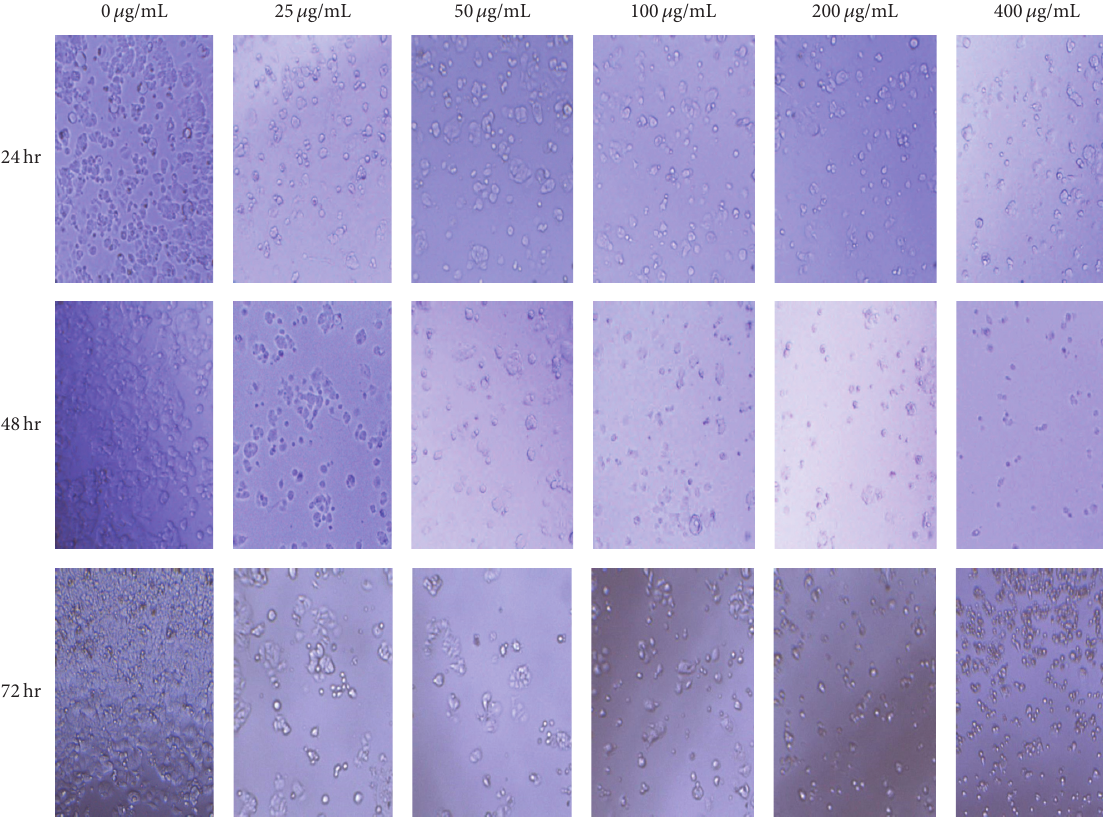
Figure 6: Morphology of human breast cancer cells (MCF-7), after 24, 48, and 72 hr incubating with the N(SO 2 pip)dpa ligand at increasing